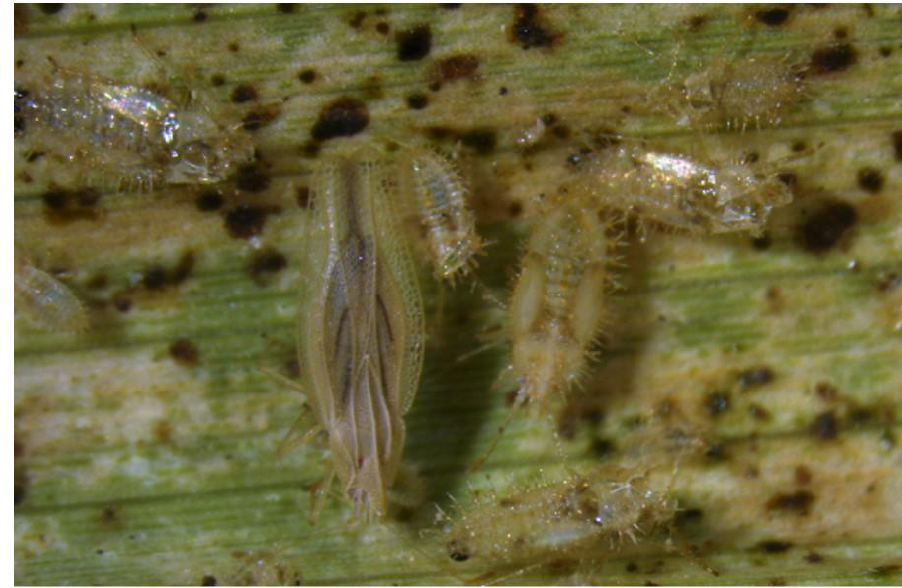
Figure 6. Leptodictya tabida adult and nymphs feeding on a sugarcane leaf. Photo: © D. Sekula, Texas A&M AgriLife.